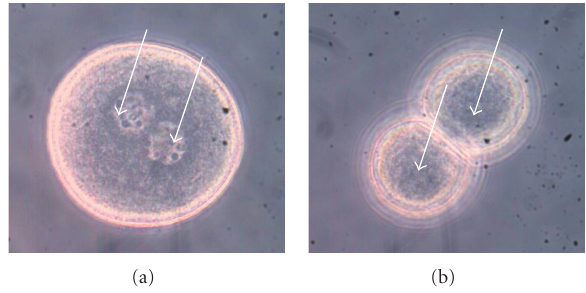
Figure 4: One-cell embryo showing a male and a female pronuclei (a), and two-cell embryo one nucleus in each, (b) 24 hours after insemination (arrows). 400 X, under phase contrast